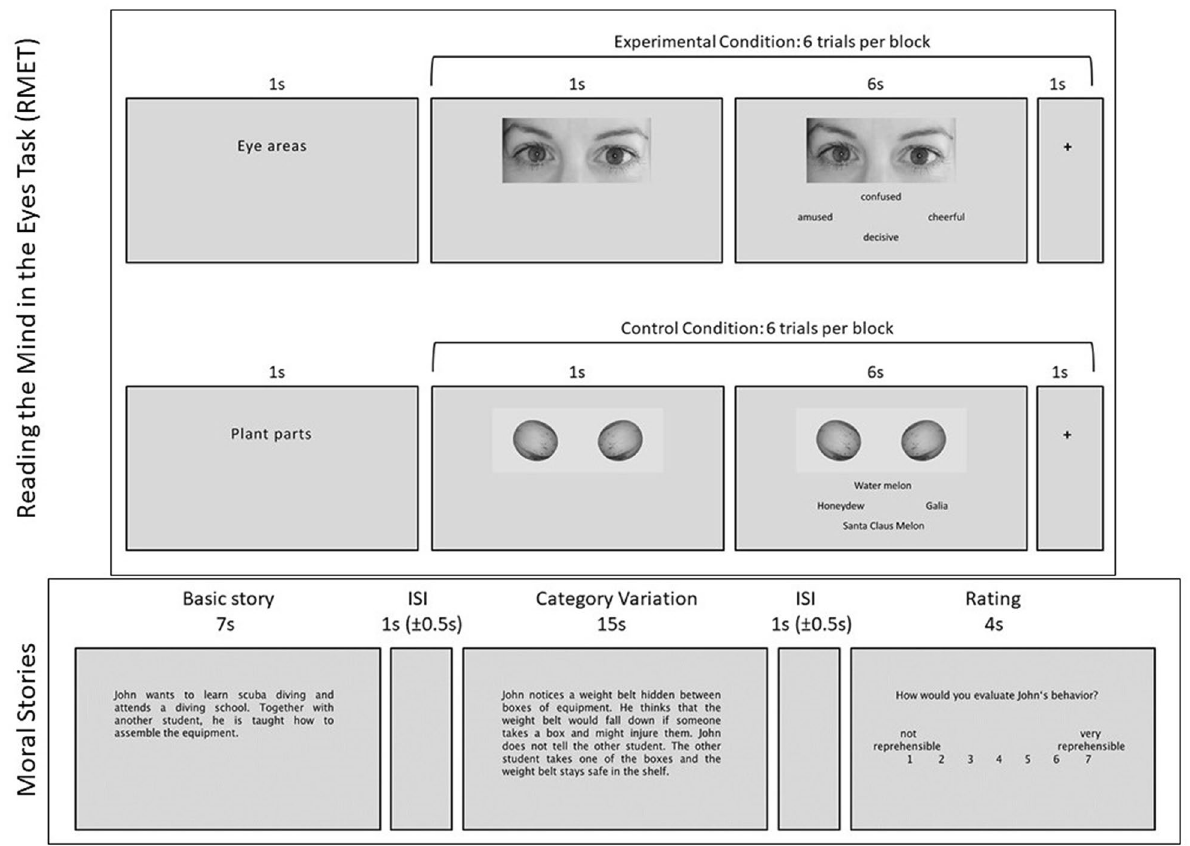
Figure 2. Example trials of both tasks; upper: reading the mind in the eyes task (RMET); lower: moral judgement task showing the NP version of the used training item (every participant had one training item per task which was not included in analyses, these two items were the same for all